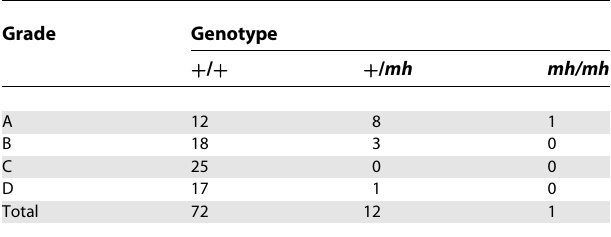
Table 2. Contingency Table for Racing Grade versus Presence or Absence of the 2-bp